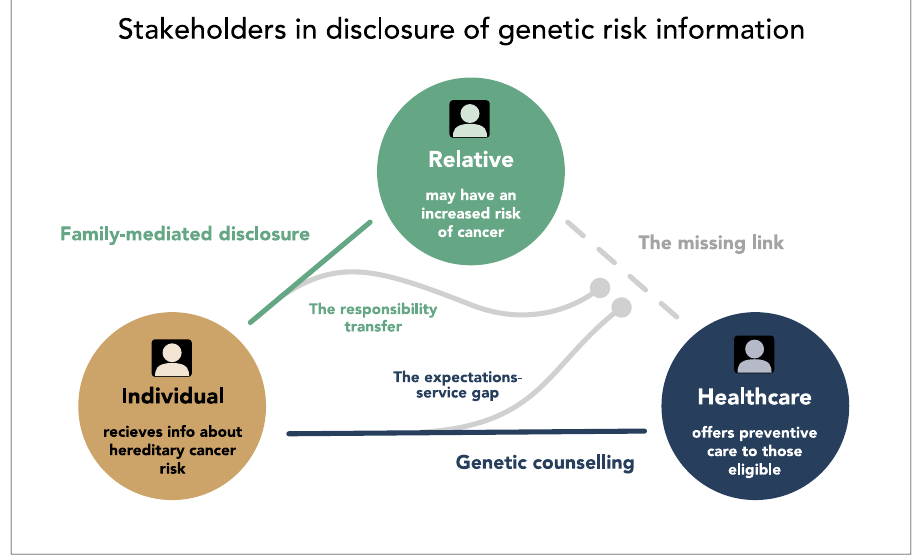
Figure 1. Conceptualization of stakeholders and their relationships based on our results.